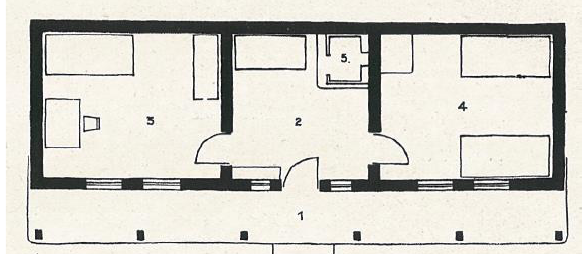
Figure 6. Common house layout in Dobrogea: 1. porch, 2. entrance and room for cooking, 3. guest /the good room, 4.